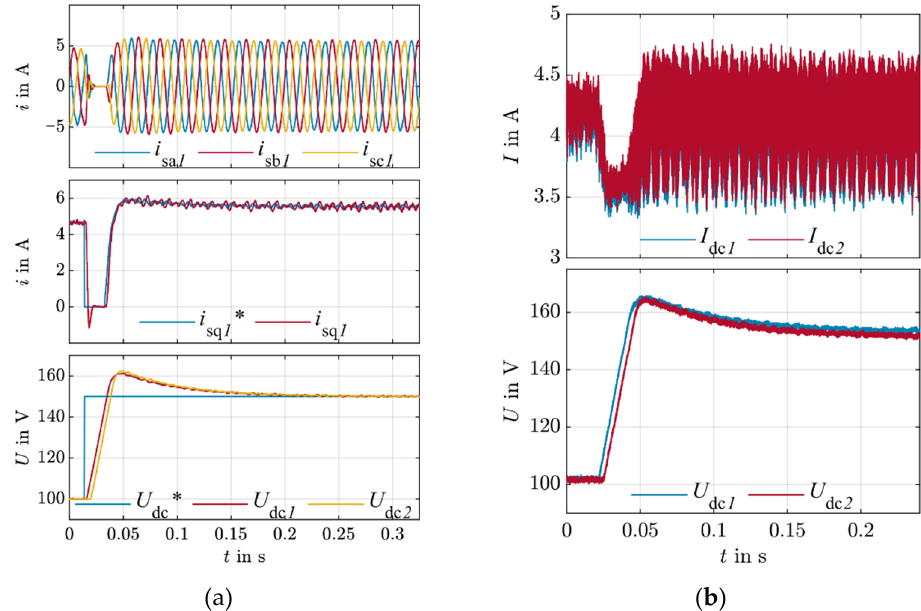
Figure 6. Voltage setpoint change from 100 V to 150 V at 5 A load condition; ( a ) Control unit recordings; ( b ) Oscilloscope recordings.